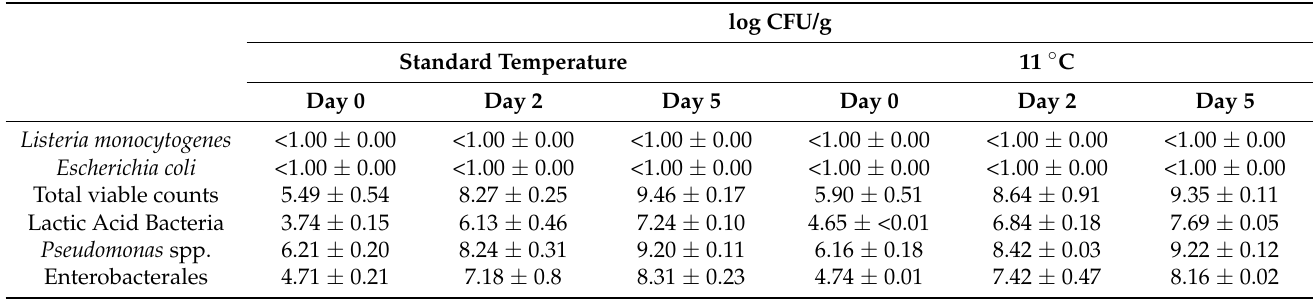
Table 1. Microbial characterization of uncooked squid and shrimp